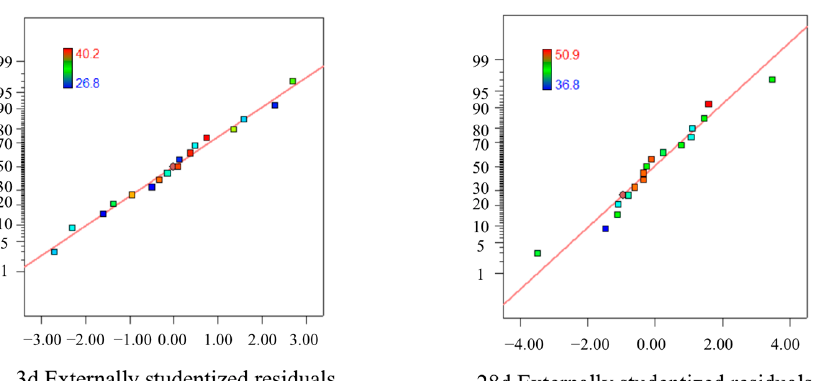
Figure 4. The relationship of predicted and actual values (3/28 d).